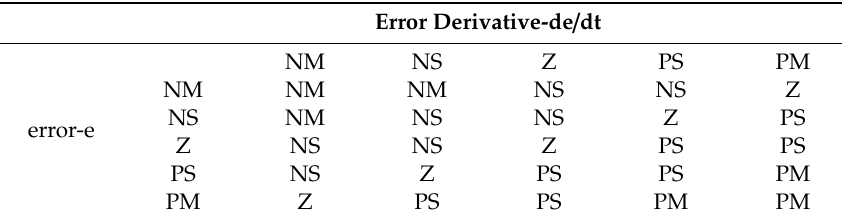
Table 13. The third version of the controller–rules.